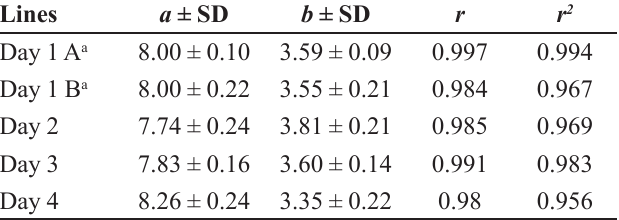
TABLE I - Parameters of calibration curve (intercept – a, slope – b, coefficient of correlation – r , and coefficient of determination - r 2 ) for gramicidin within the range 5.00 to 25.3 µg/mL Lines